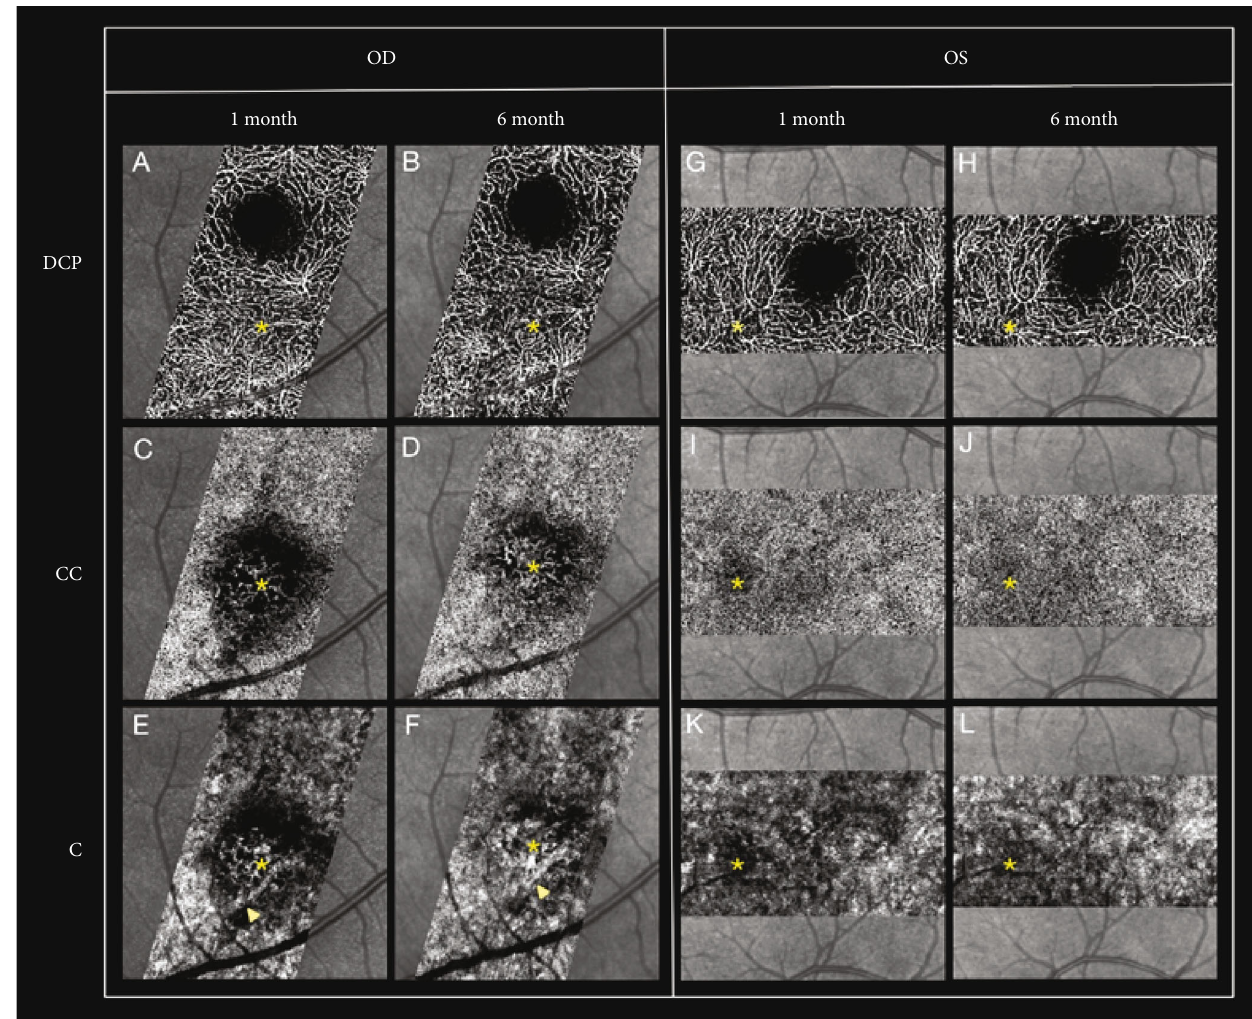
Figure 2: Spectral domain-optical coherence tomography angiography fi ndings at various levels during the 1-month and 6-month follow-up. An asterisk marks the center of the lesion. Normal perfusion is seen in the deep capillary plexus (DCP) of the right eye at 1 month (A) and at 6-month (B) follow-up, as well as in the left eye at 1 month (G) and 6 months (H). Perfusion de fi cit of the right eye is noted at the area of the lesion in the choriocapillaris (C) and choroid (E), with choroidal vascular dilatation (arrowhead). Similar areas of choriocapillaris (I) and choroidal (K) hypoperfusion is seen in the fellow eye. Improved perfusion is noted at 6-month follow-up in both eyes (D, F, J, L), with persistent choroidal vascular dilatation in the right eye (F,